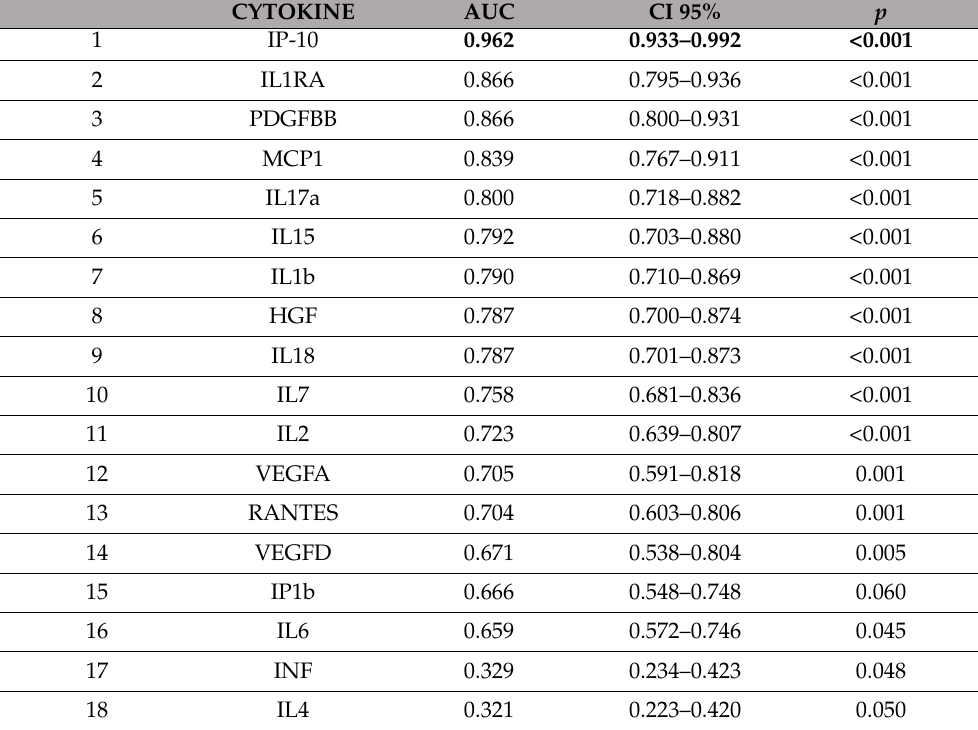
Table 2. Area under the receiver operating characteristic curve (AUROC) analysis of the 18 significant cytokines. The bold is to indicate statistical significance.